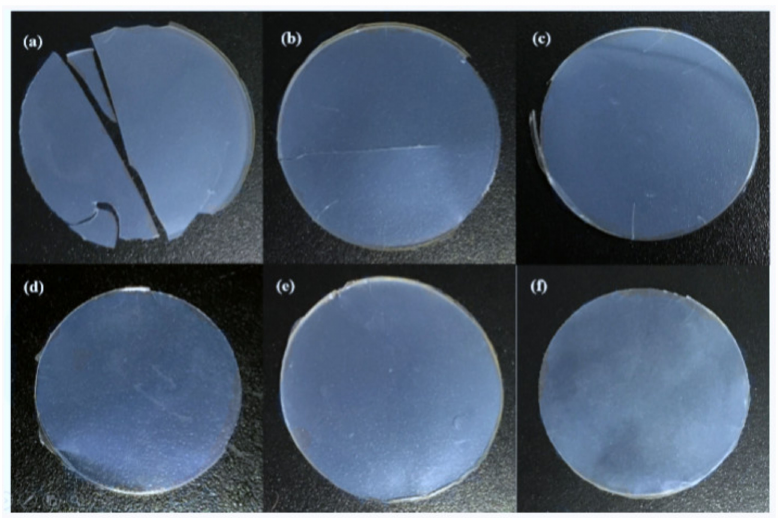
Figure 1. Macroscopic CNC/DS films with different percentages of D-sorbitol: ( a ) 0; ( b ) 2%; ( c ) 3%; ( d ) 4%; ( e ) 5%; ( f )